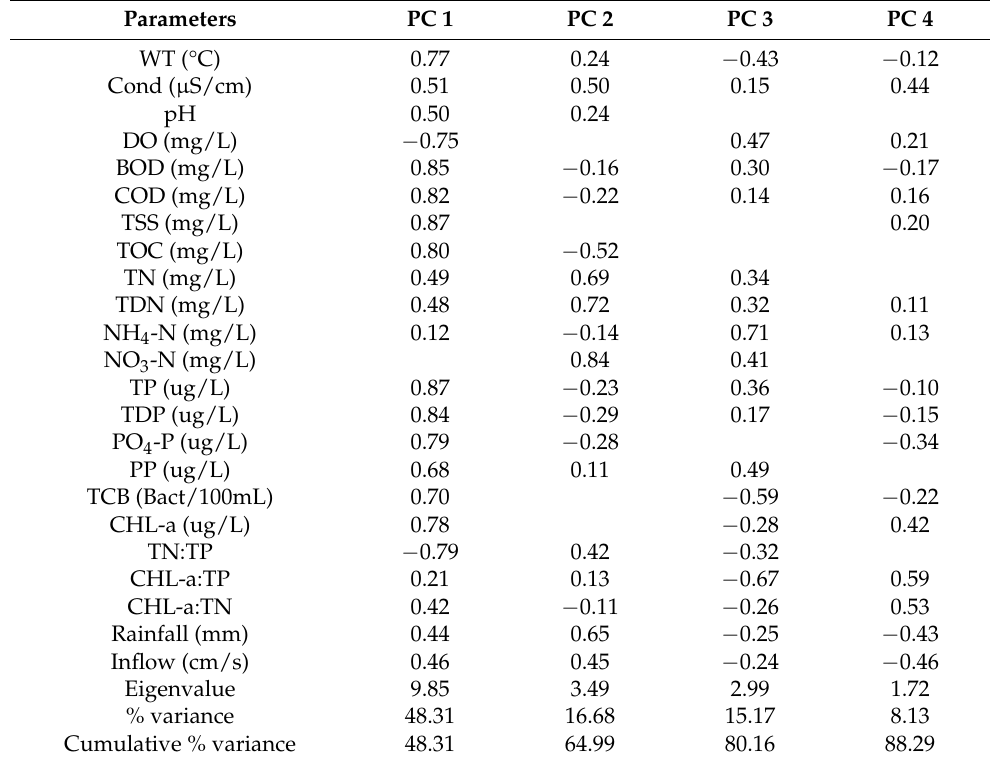
Table 5. Loadings of the water quality variables, precipitation, and inflow in the significant PCs (PP–particulate